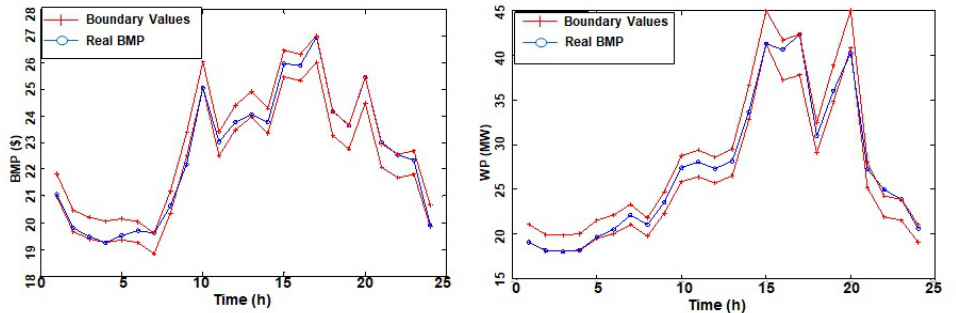
Figure 5. BMP and WP of PIs with PINC